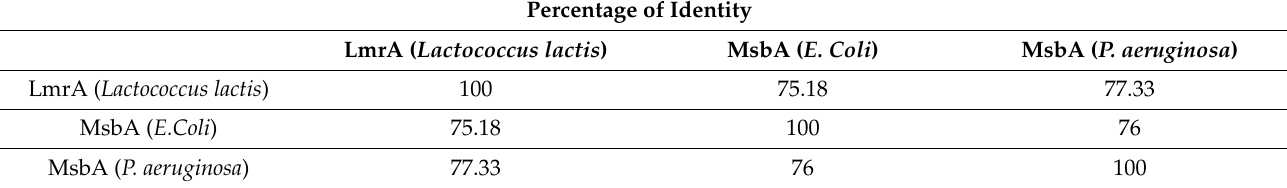
Table 4. Amino acid sequence alignment of LmrA L. lactis (P97046), MsbA E.Coli (P60752) and